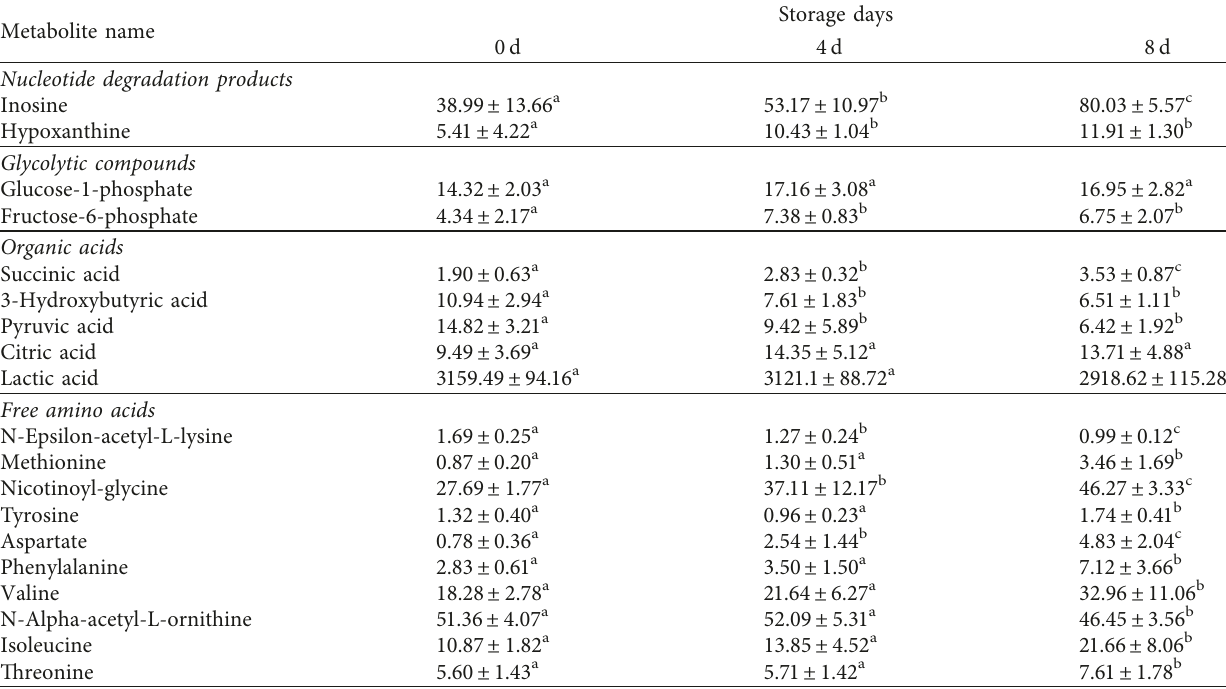
Table 2: Effects of chilled ageing conditioning on water-soluble flavour precursors.